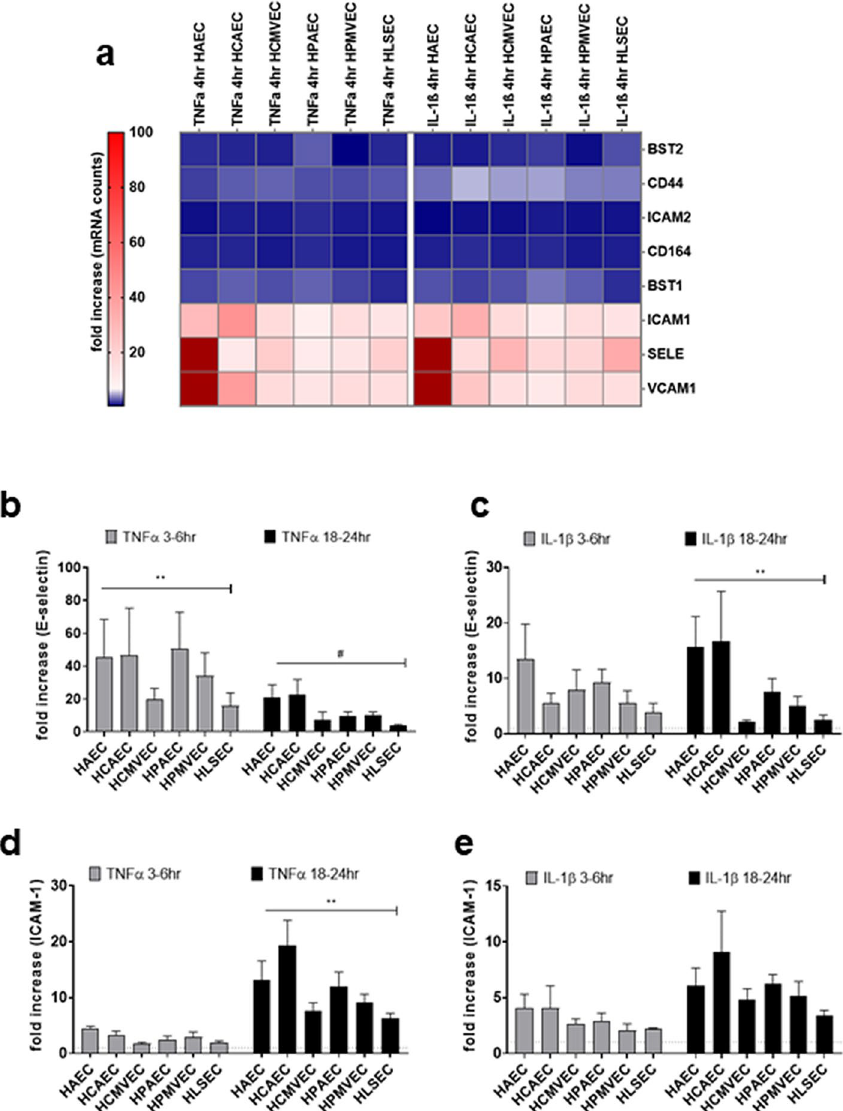
Figure 4. Adhesion molecule expression by cytokine-activated endothelial cells. ( a ) After 4 h activation with TNFα (20 ng/mL) or IL-1β (20 ng/mL), stimulated endothelial cells were lysed in RLT buffer, and mRNA for immune response genes was measured by nanostring. Absolute mRNA counts for endothelial adhesion molecule genes are presented in the heat map. ( b , c ) After 4 h or 18-24 h, stimulated endothelial cells were detached and TNFα ( b ) and IL-1β ( c ) induced cell surface E-selectin was measured by flow cytometry. Results are presented as fold increase in the median fluorescence intensity of cell surface E-selectin, normalized within each experiment to the untreated condition for each cell type.( d , e ) After 4 h or 18-24 h, stimulated endothelial cells were detached and TNFα ( d ) and IL-1β ( e ) induced cell surface ICAM-1 was measured by flow cytometry. Results are presented as fold increase in the median fluorescence intensity of cell surface ICAM-1, normalized within each experiment to the untreated condition for each cell type. ( f , g ) After 4 h or 18-24 h, stimulated endothelial cells were detached and TNFα ( f ) and IL-1β ( g ) induced cell surface VCAM-1 was measured by flow cytometry. Results are presented as fold increase in the median fluorescence intensity of cell surface VCAM-1, normalized within each experiment to the untreated condition for each cell type. (TNFα and IL-1β 4 h, n = 4; 18-24 h, n = 5–6 donors per endothelial cell type). # p < 0.1, * p < 0.05, ** p < 0.001 comparing HAEC and HCAEC to HLSEC by two way ANOVA followed by uncorrected Fisher’s LSD. ( h ) mRNA and ( i ) fold increase in the MFI of cell surface expression of VCAM-1 was measured on aortic HAEC and liver HLSEC endothelial cells stimulated with IL-4 (20 ng/mL) for 4 h or 24 h (n = 3 donors per endothelial cell type). Results are presented as mean ± SEM. # p < 0.1 comparing HAEC to HLSEC, by two way ANOVA and uncorrected Fishers